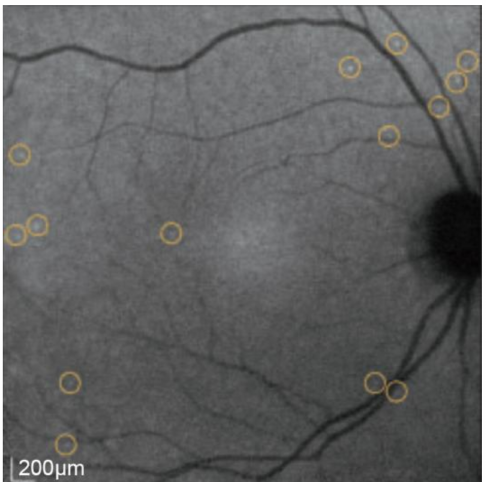
Figure 5. DARC imaging showing the circled apoptosing RGCs following intravenous injection of ANX776 in a human